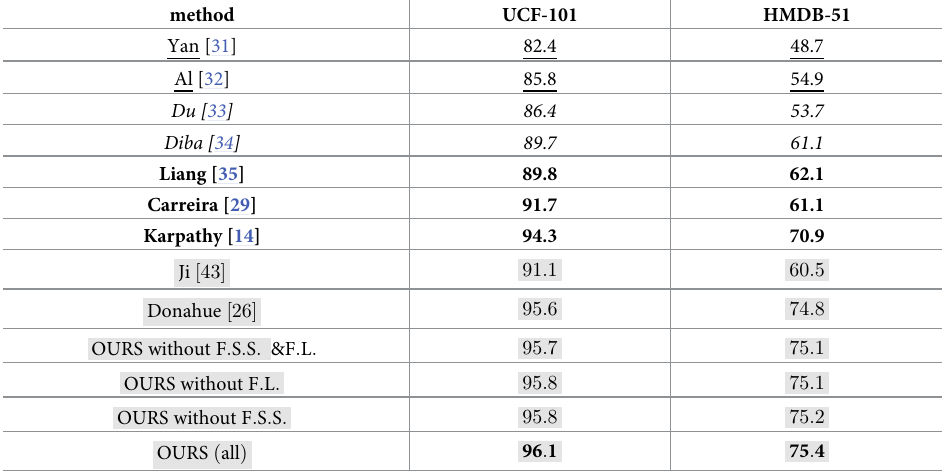
Table 7. Accuracy comparison of different methods in UCF-101 and